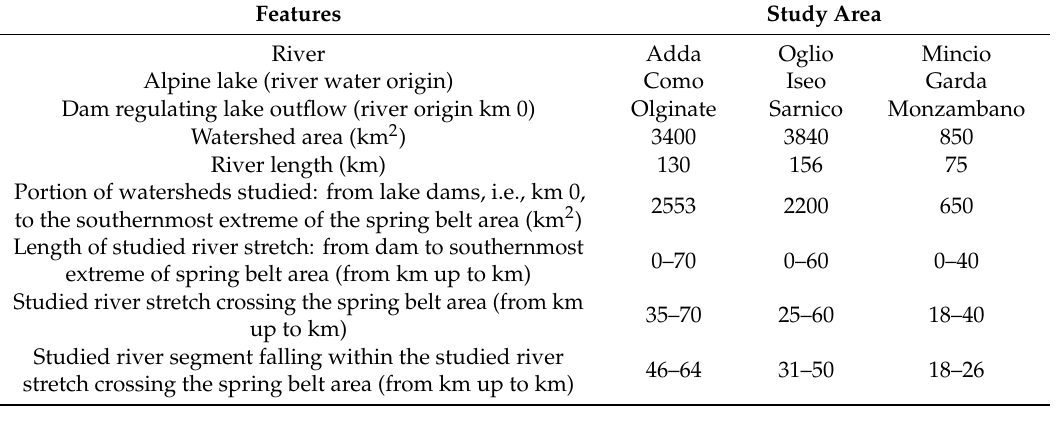
Table 1. Physical features of the Adda, Oglio, and Mincio watersheds and delimitation of the portion of the watersheds which are the object of this study.